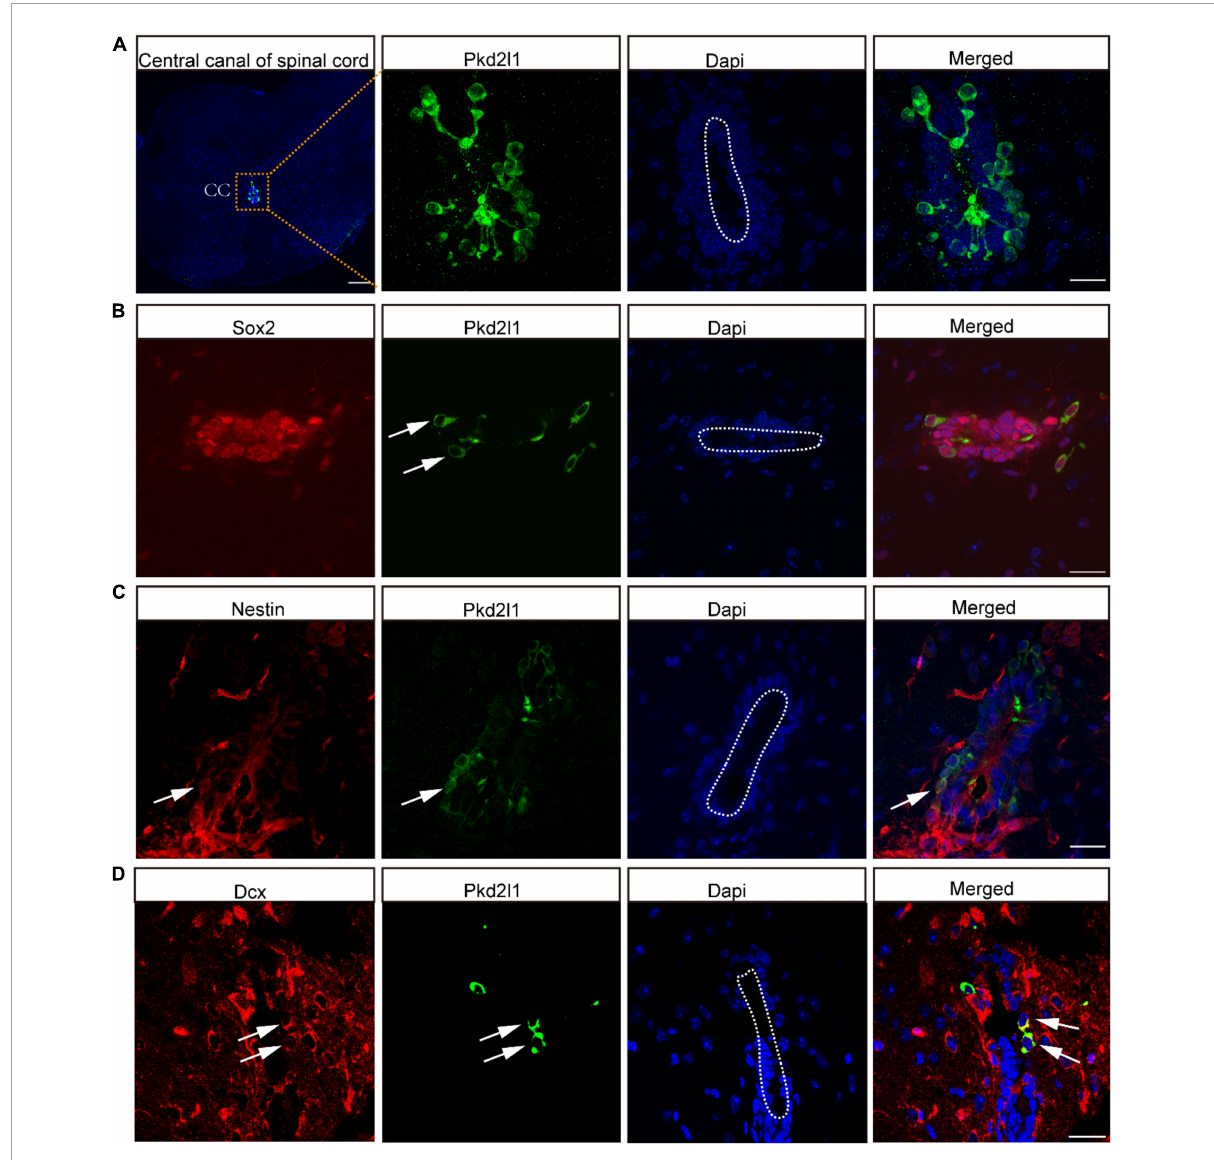
FIGURE1 Cerebrospinal fluid-contacting neurons (CSF-cNs) expressed neural stem cell (NSC) markers in vivo . (A) Cross-section of the spinal cord and CSF-cNs of the central canal. (B) Representative images showed that CSF-cNs expressed NSC markers for Sox2. (C) Representative images showed that CSF-cNs expressed NSC markers for Nestin. (D) Representative images displayed that CSF-cNs expressed neuronal migration markers for Dcx. White arrows: Nestin, Sox2, and Dcx positive CSF-cNs. Scale bar represents 100 µ